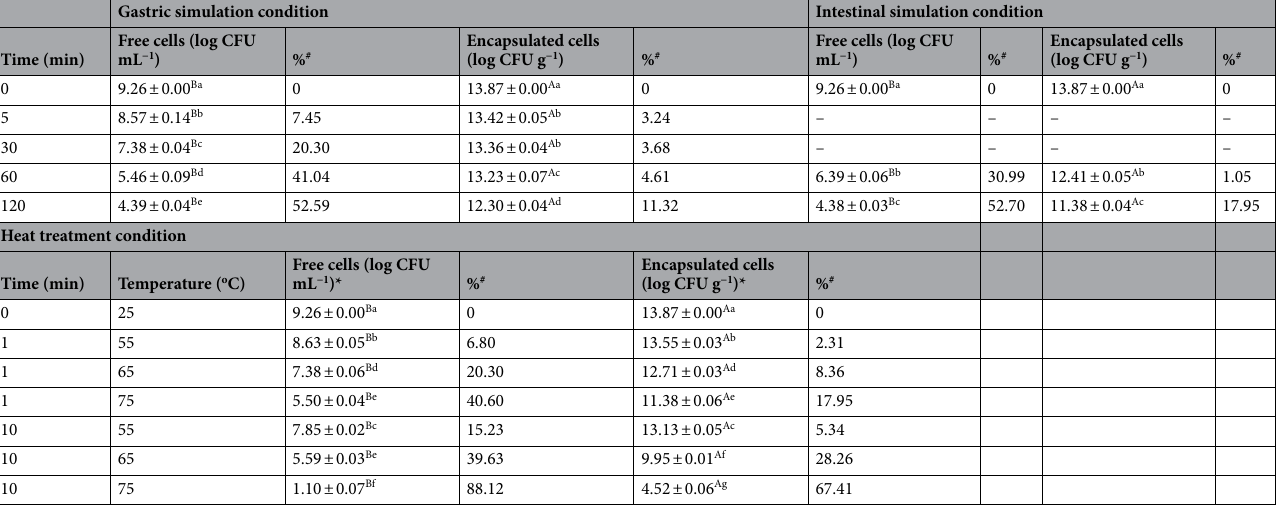
Table 1. Viability of free and encapsulated probiotic cells under simulated gastric and intestinal conditions, and on heat treatment. %# Percent reduction in cell viability. Means followed by different capital letters differ statistically on the line; means followed by distinct lowercase letters differ statistically in the column ( p < 0.05). *Results of triplicate